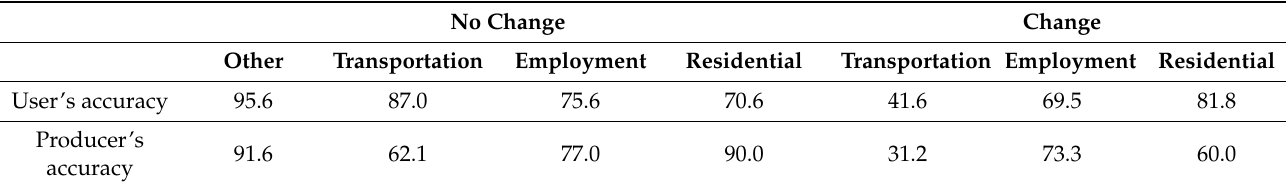
Table 2. User’s and producer’s accuracy of land use change